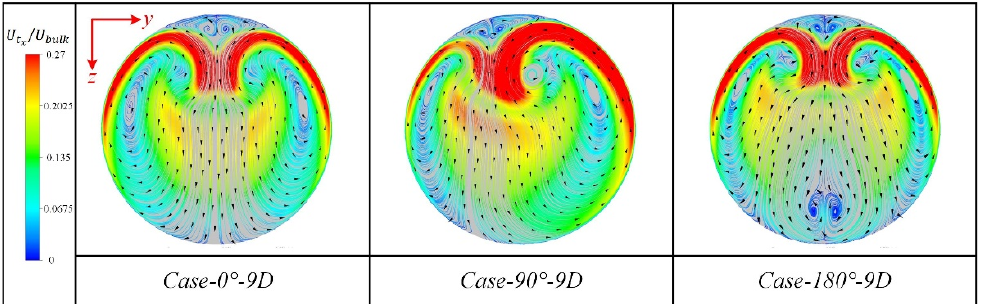
Figure 13. Streamlines and tangential velocity vectors at outlets of downstream bends in Case-0°-9D , Case-90°-9D , and Case-180°-9D.